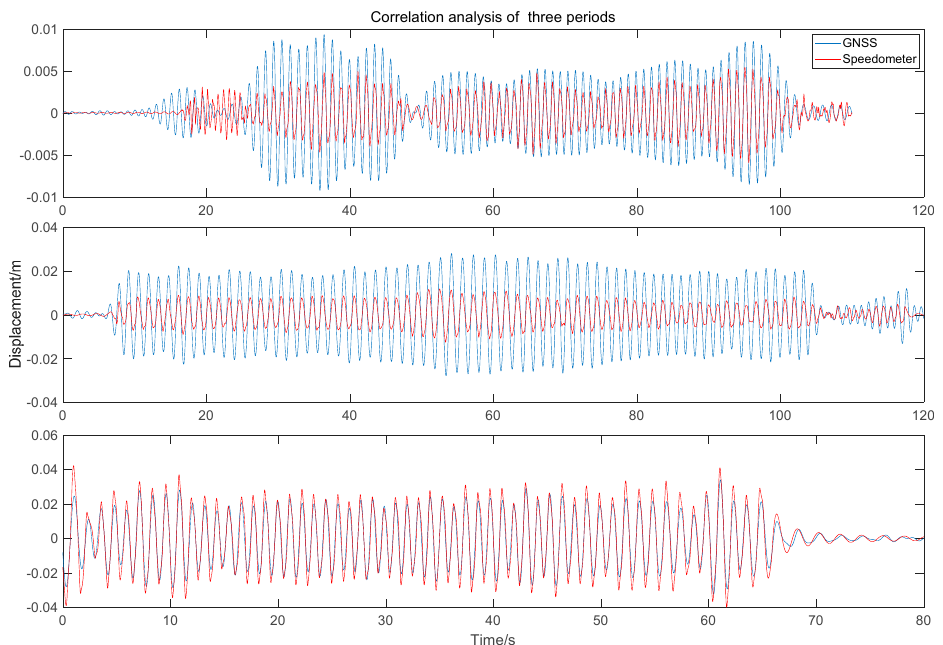
Figure 15. Correlation analysis of integral displacement of the speedometer and IMF2 component in three periods.